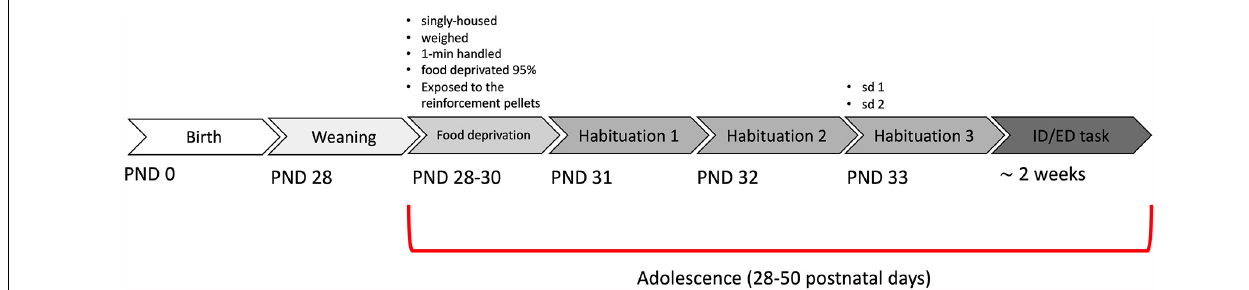
FIGURE 2 | Timeline of the experiment in adolescent mice.